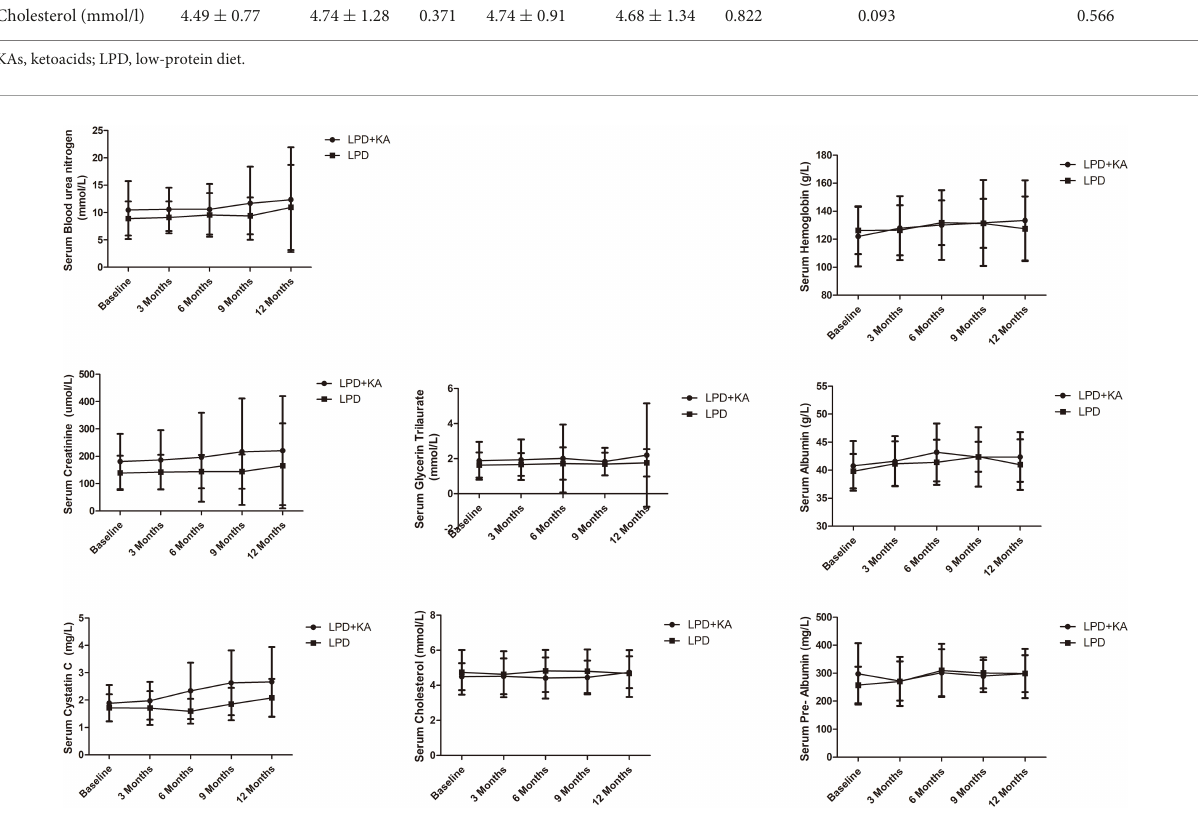
FIGURE2 Biochemical data of study participants at baseline and every 3 months during follow-up. KA, ketoacids; LPD, low-protein